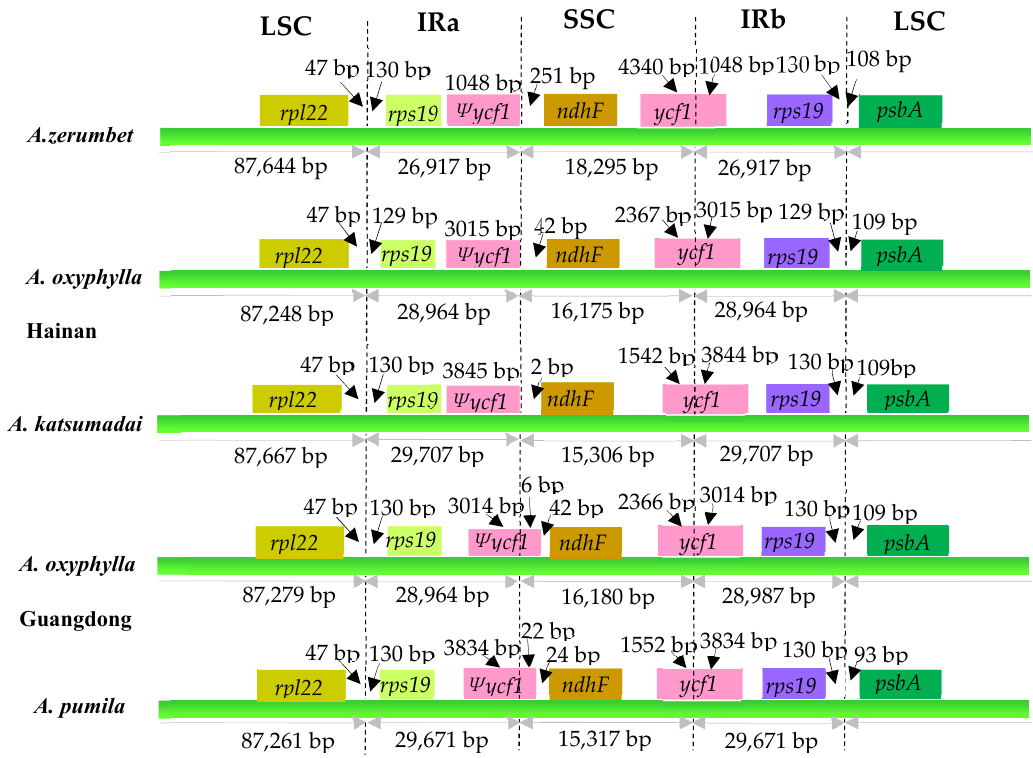
Figure 5. Comparison of the borders of the LSC, SSC, and IR regions among five Alpinia chloroplast genomes. Ψ , pseudogenes. Boxes above the main line indicate the adjacent border genes. The figure is not to scale with respect to sequence length, and only shows relative changes at or near the IR / SC